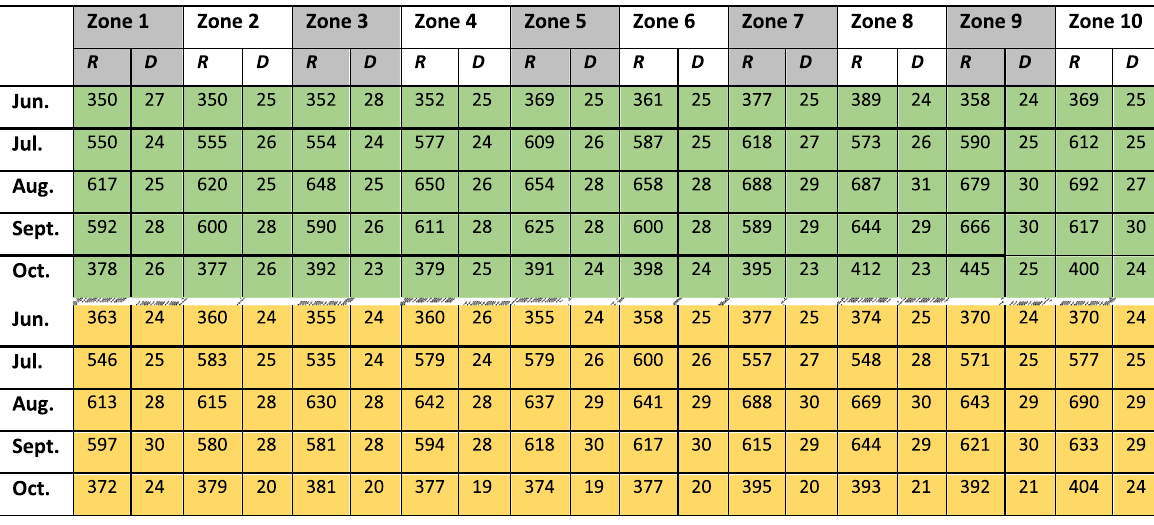
Table 15 Rainfall data for 1948 – 2018 (Orange) and 2019 (Green)